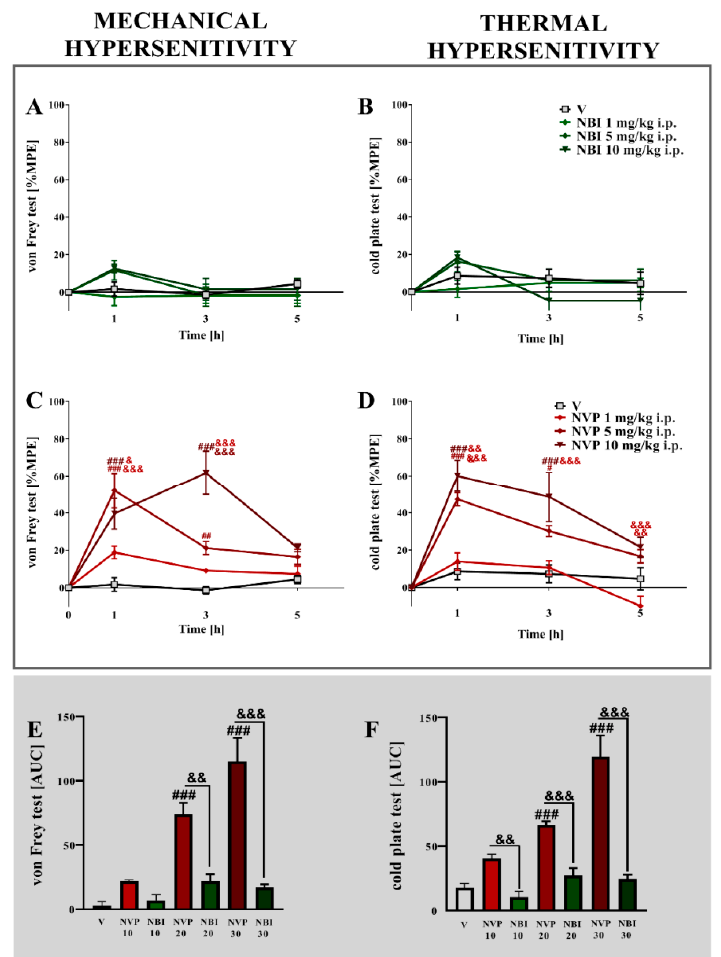
Figure 8. Comparison of the analgesic effects of intraperitoneal ( i.p .) administration of different doses (1, 5, or 10 mg/kg) of (±)-NBI 74330 ( A , B ) and NVP CXCR2 20 ( C , D ) on the 7th day after chronic constriction injury in mice. The effects of single i.p . NBI and NVP injections on mechanical ( A , C ) and thermal ( B , D ) hypersensitivity were measured. The results are presented as a percentage of the maximal possible effect (% MPE = (post-drug response − basal response)/(cutoff value − basal response) × 100%) of drug action ( A – D ), and the area under the curve (AUC) for each test was calculated ( E , F ). Data are presented as the means ± SEM (4–6 mice per group). The results were evaluated using one-way ANOVA followed by Bonferroni’s test for comparisons of selected pairs measured separately at each time point. Additionally, the results were evaluated using two-way ANOVA to determine the time × drug interaction. # p < 0.05 and ### p < 0.001 for the comparison of vehicle-treated animals with all groups at the indicated time points. & p < 0.05, && p < 0.01, and &&& p < 0.001 for the comparison of different doses of NVP, and the same doses of NVP with NBI. Abbreviations: vehicle, V; (±)-NBI 74330, NBI; NVP CXCR2 20, NVP.